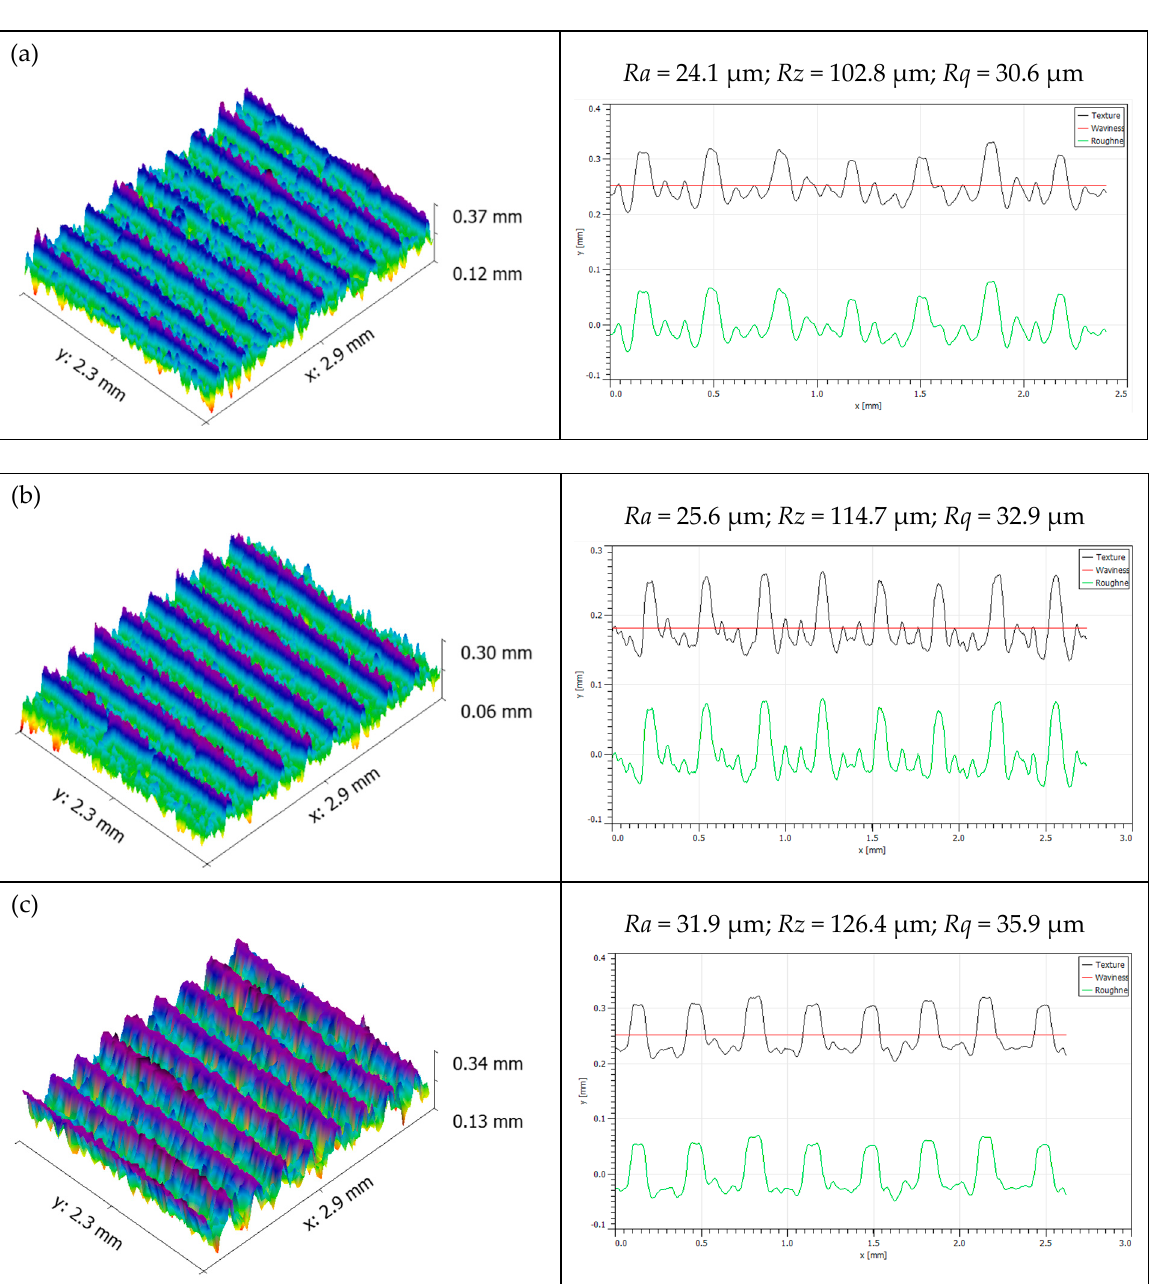
Figure 5. Influence of FDM parameters on Rq: ( a ) Layer thickness vs. Raster angle; and ( b ) Raster angle vs. Raster width